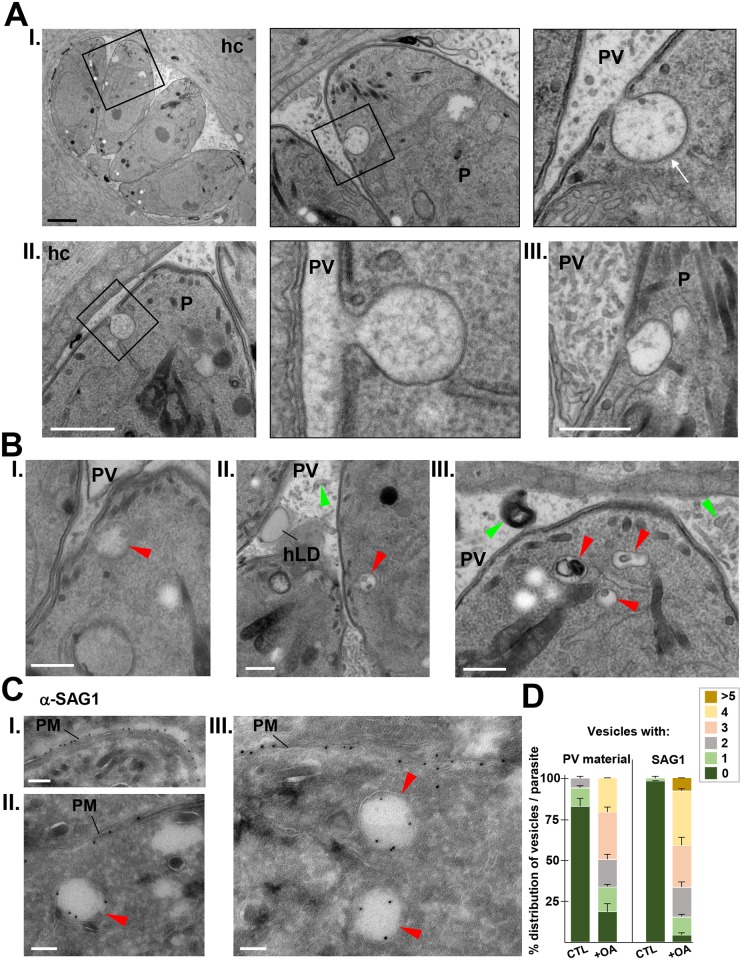
Ultrastructural detection of endocytic-like structures in Toxoplasma.A-B. Transmission EM of parasites in HFF incubated with 0.2 mM OA for 24 h. In A, panels I-III show three plasma membrane invaginations decorated with a cytoplasmic coat (arrow in I) and whose content displays resemblance with the material present in the PV lumen, suggestive of endocytic events. P, parasite; hc, host cell. Scale bars, 0.3 μm. In B, panels I-III illustrate intraparasitic vesicles containing osmiophilic material similar to that present in the PV lumen close to the parasite (red arrowheads). C. ImmunoEM for SAG1 detection, on parasites in HFF incubated with 0.2 mM OA for 24 h for SAG1 detection. Anti-SAG1-gold particles were observed on the limiting membrane of intracytoplasmic vesicles (red arrowheads). This antibody recognizes SAG1 epitopes on the extracellular moiety of SAG1 (panel I), making the SAG1 staining distributed on the internal leaflet of the organellar membrane, as expected for an endocytic event (panels II and III). PM, parasite plasma membrane. D. Quantification of intracytoplasmic vesicles either containing PV material or SAG1 staining in control and OA-loaded parasites. Data are means ± SD of 65 to 80 PV observed. All scale bars in A-C, 0.1 μm.